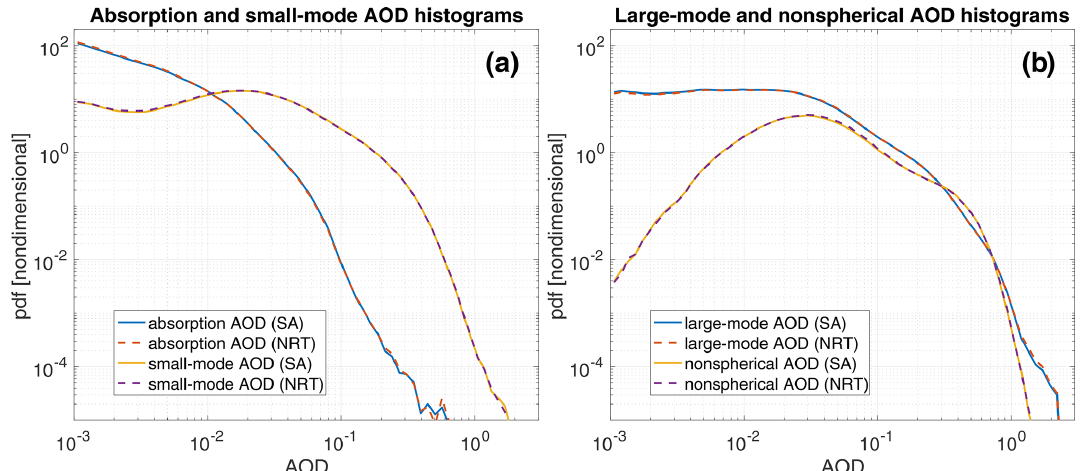
Figure 9. Normalized probability density functions for select MISR particle property retrievals in March, April, and May 2020. Solid lines represent SA retrievals and dashed lines represent NRT retrievals. (a) Absorption AOD and small-mode AOD retrievals. (b) Large-mode AOD and nonspherical AOD retrievals. The differences between the SA and NRT products are